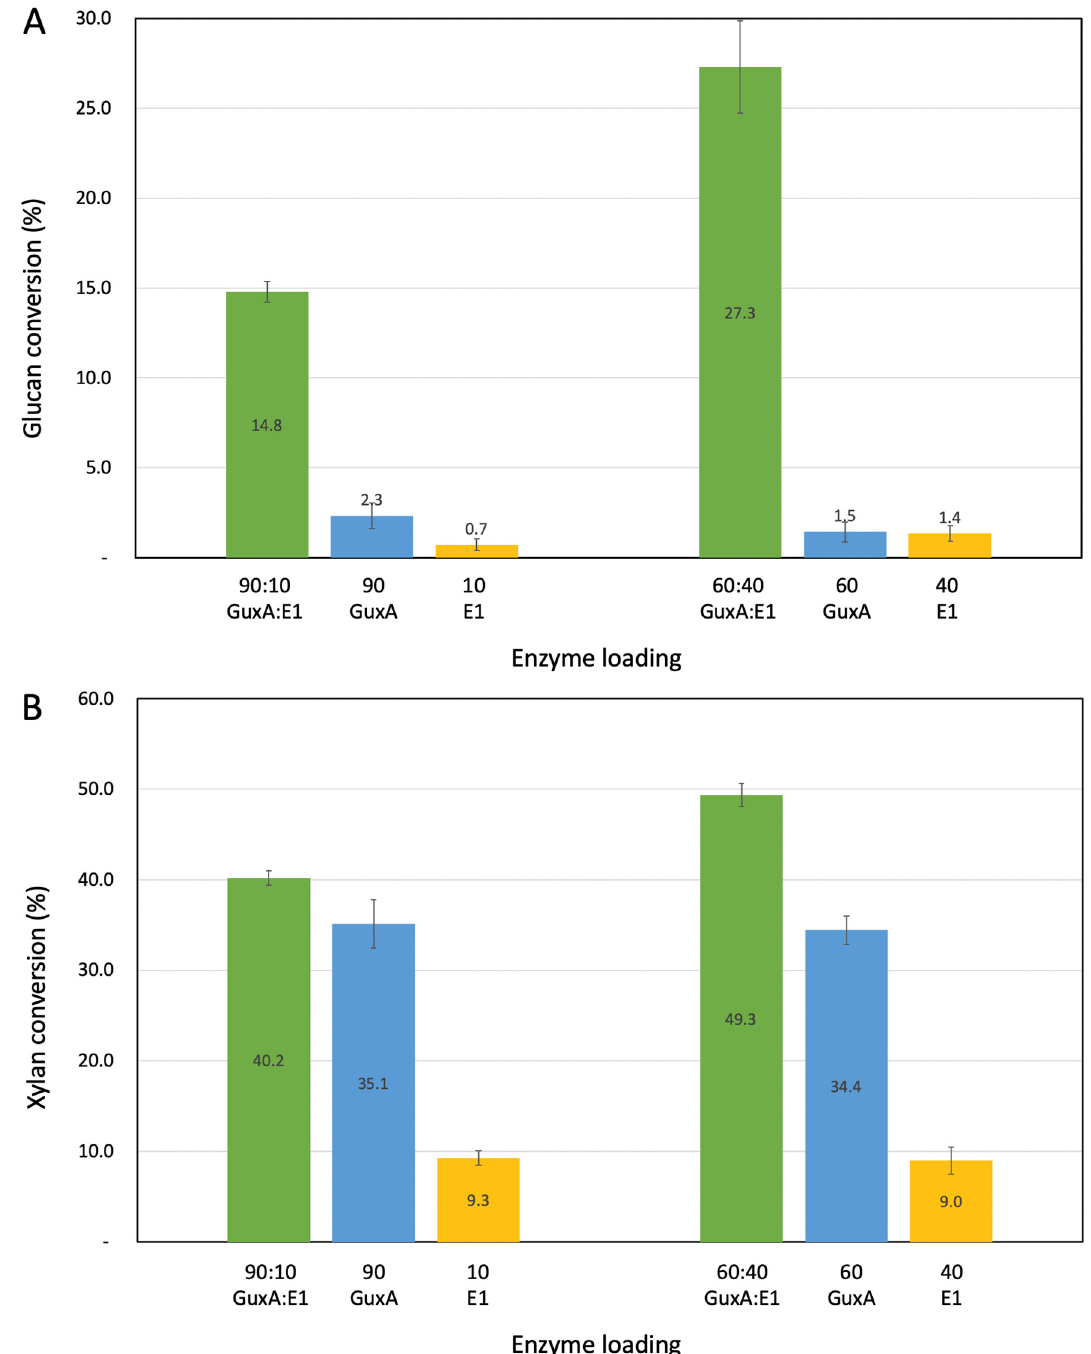
Figure 3. Investigation of the deconstruction of APCS: Glucan ( A ) and xylan ( B ) conversion using single enzymes and the two most extreme loadings of GuxA and E1 from Figure 2. Digestions were carried out for 72 h.